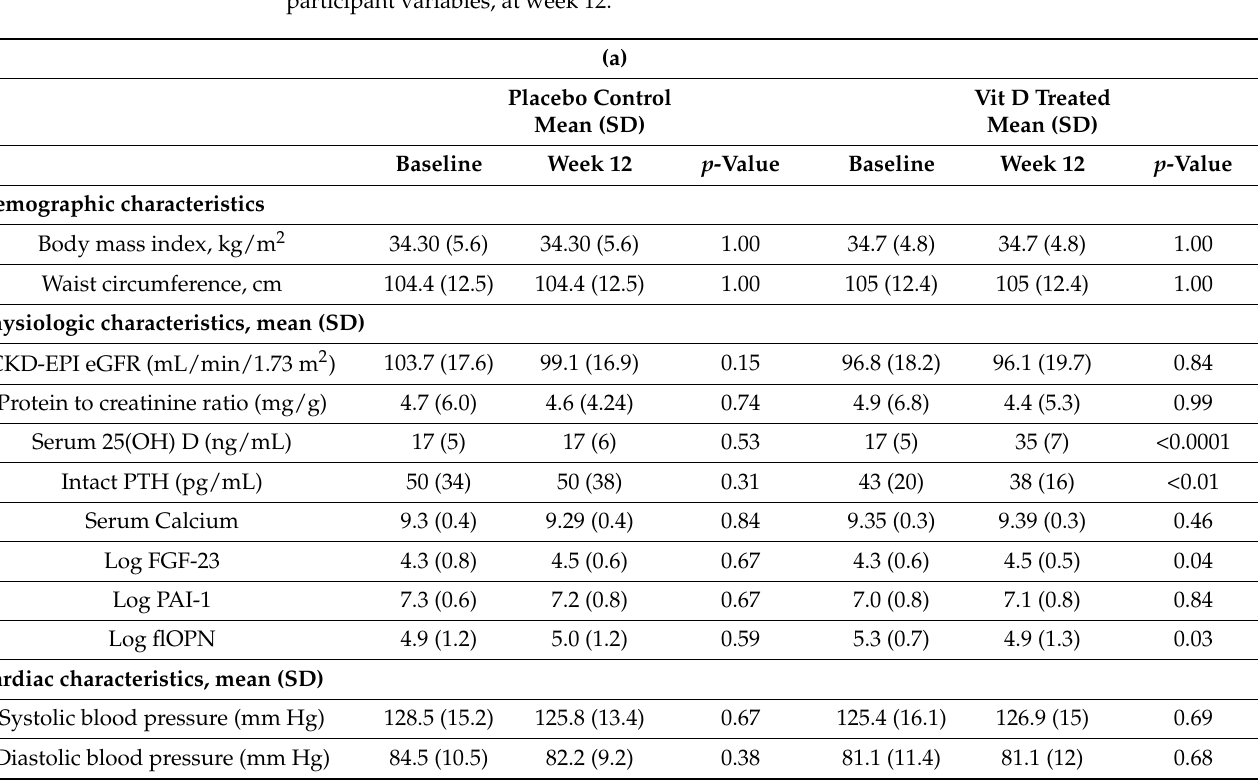
Table 2. ( a ) Change in patient characteristics from baseline and week 12 for placebo control and Vitamin D treated groups. ( b ) Multivariate regression analysis of the relationship between Vit D and participant variables, at week